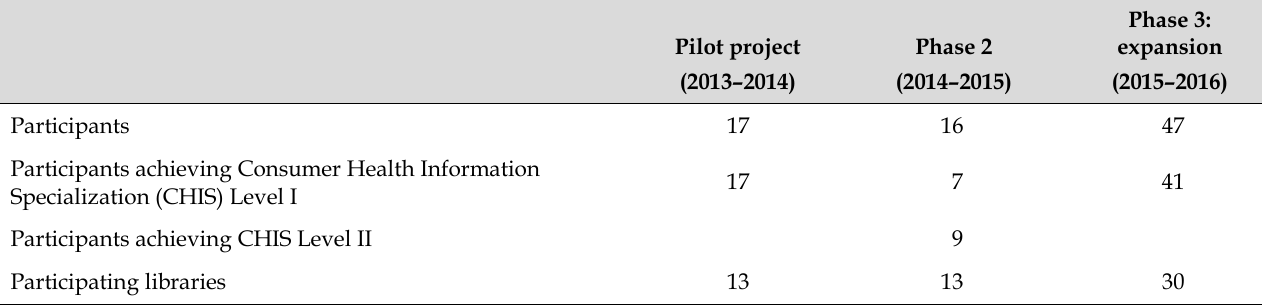
Table 1 Health Information Specialists Program: participation